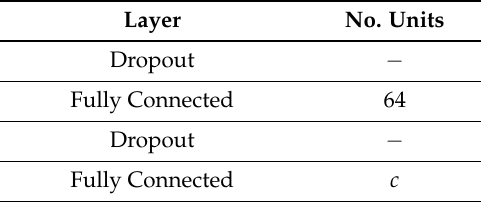
Table 2. Classifier Architecture.